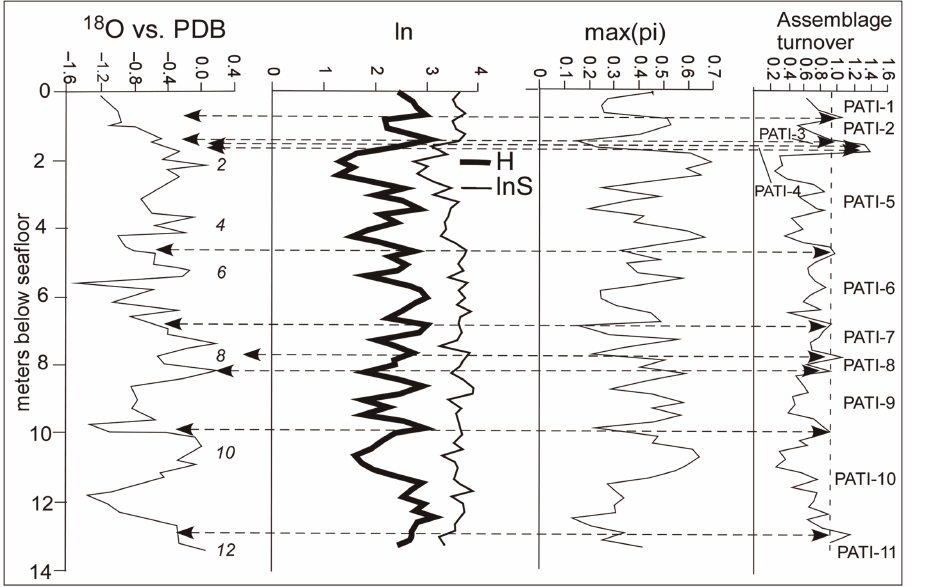
Figure 2. d 18O from Oba et al . [ 53 ] , the information function H, species richness S (graphed as lnS to facilitate comparison with H), max(p i ) and between sample assemblage turnover index (ATI s ) [from this paper] in the Upper Quaternary, ODP Hole 994C, Blake Ridge. Numbers in italics indicate marine isotope stages; PATI are peak-bounded ATI s